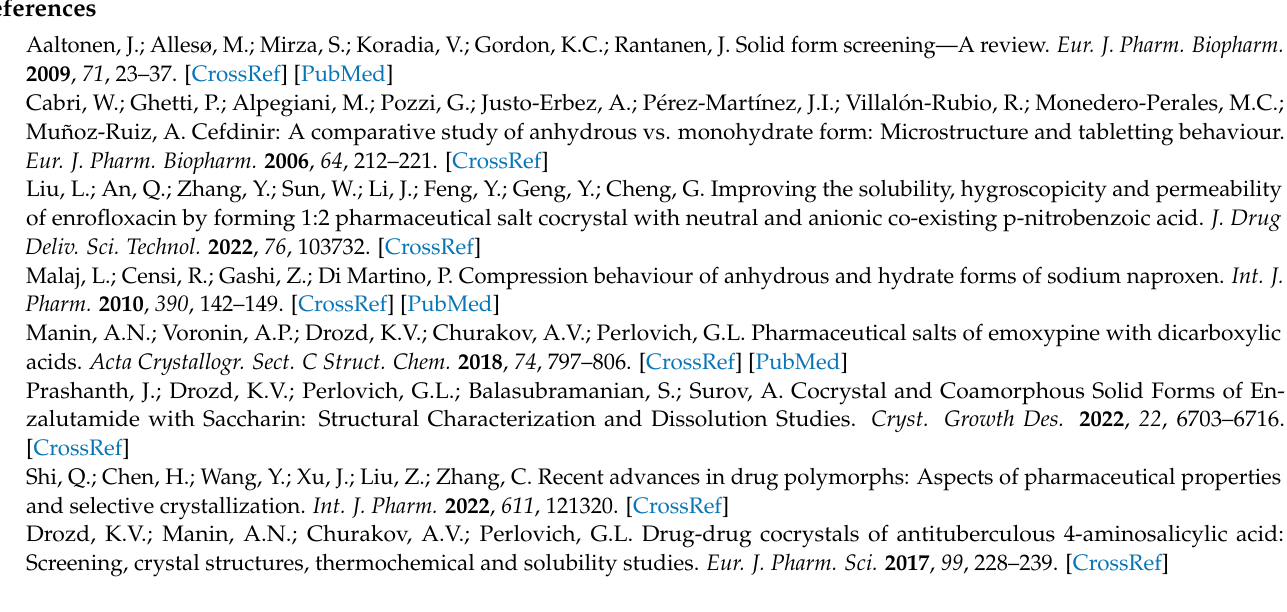
Figure S6: Results of PXRD analysis of the residual materials collected at the end of the dissolution experiments. Table S1: Hydrogen bond geometries for the NFT hydrated